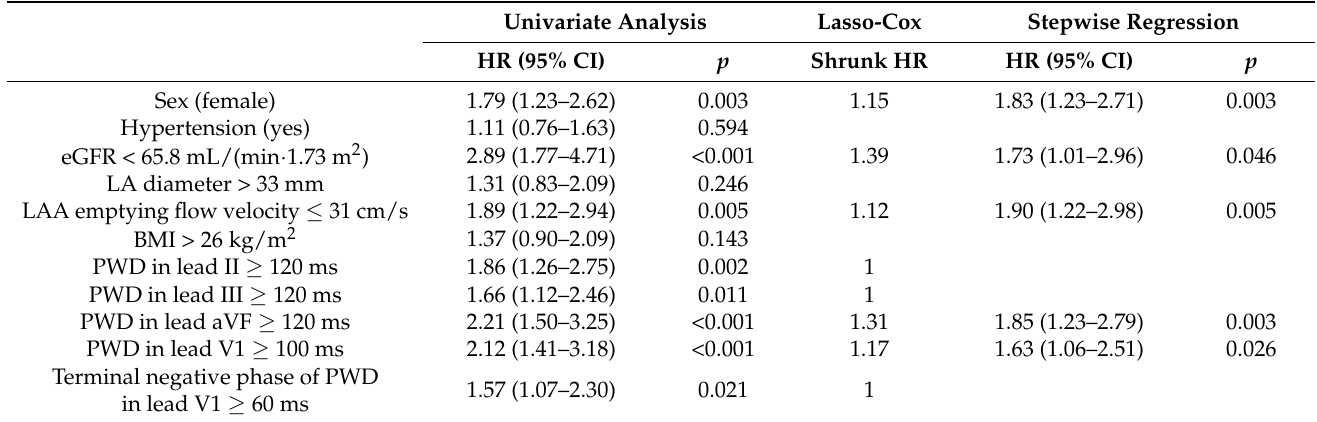
Table 2. Univariate, lasso-based, and stepwise Cox regression